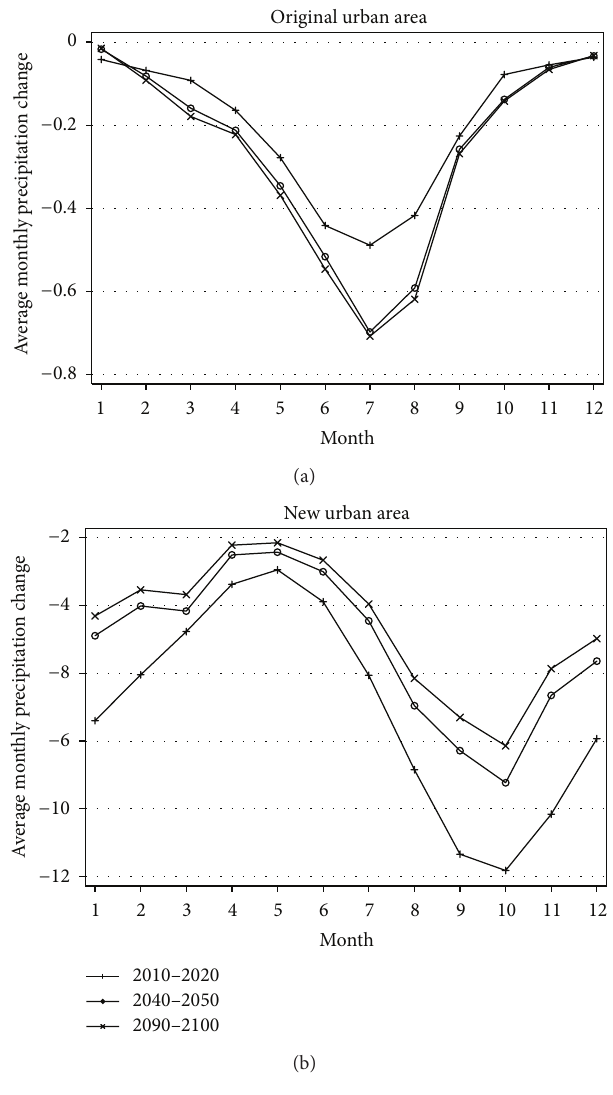
Figure 7: Effects of future urban expansion on average monthly precipitation in urban area in the Northeast megalopolis, USA (unit: